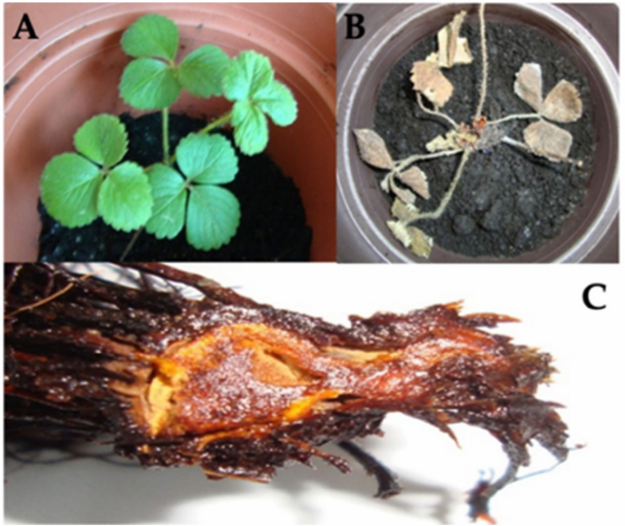
Figure 3. Pathogenicity tests on strawberry plants (var. Camino Real): ( A ) healthy control plant with- out symptoms of drying, ( B ) plant with wilting and death of foliage, ( C ) cross-section of strawberry root showing ascending root